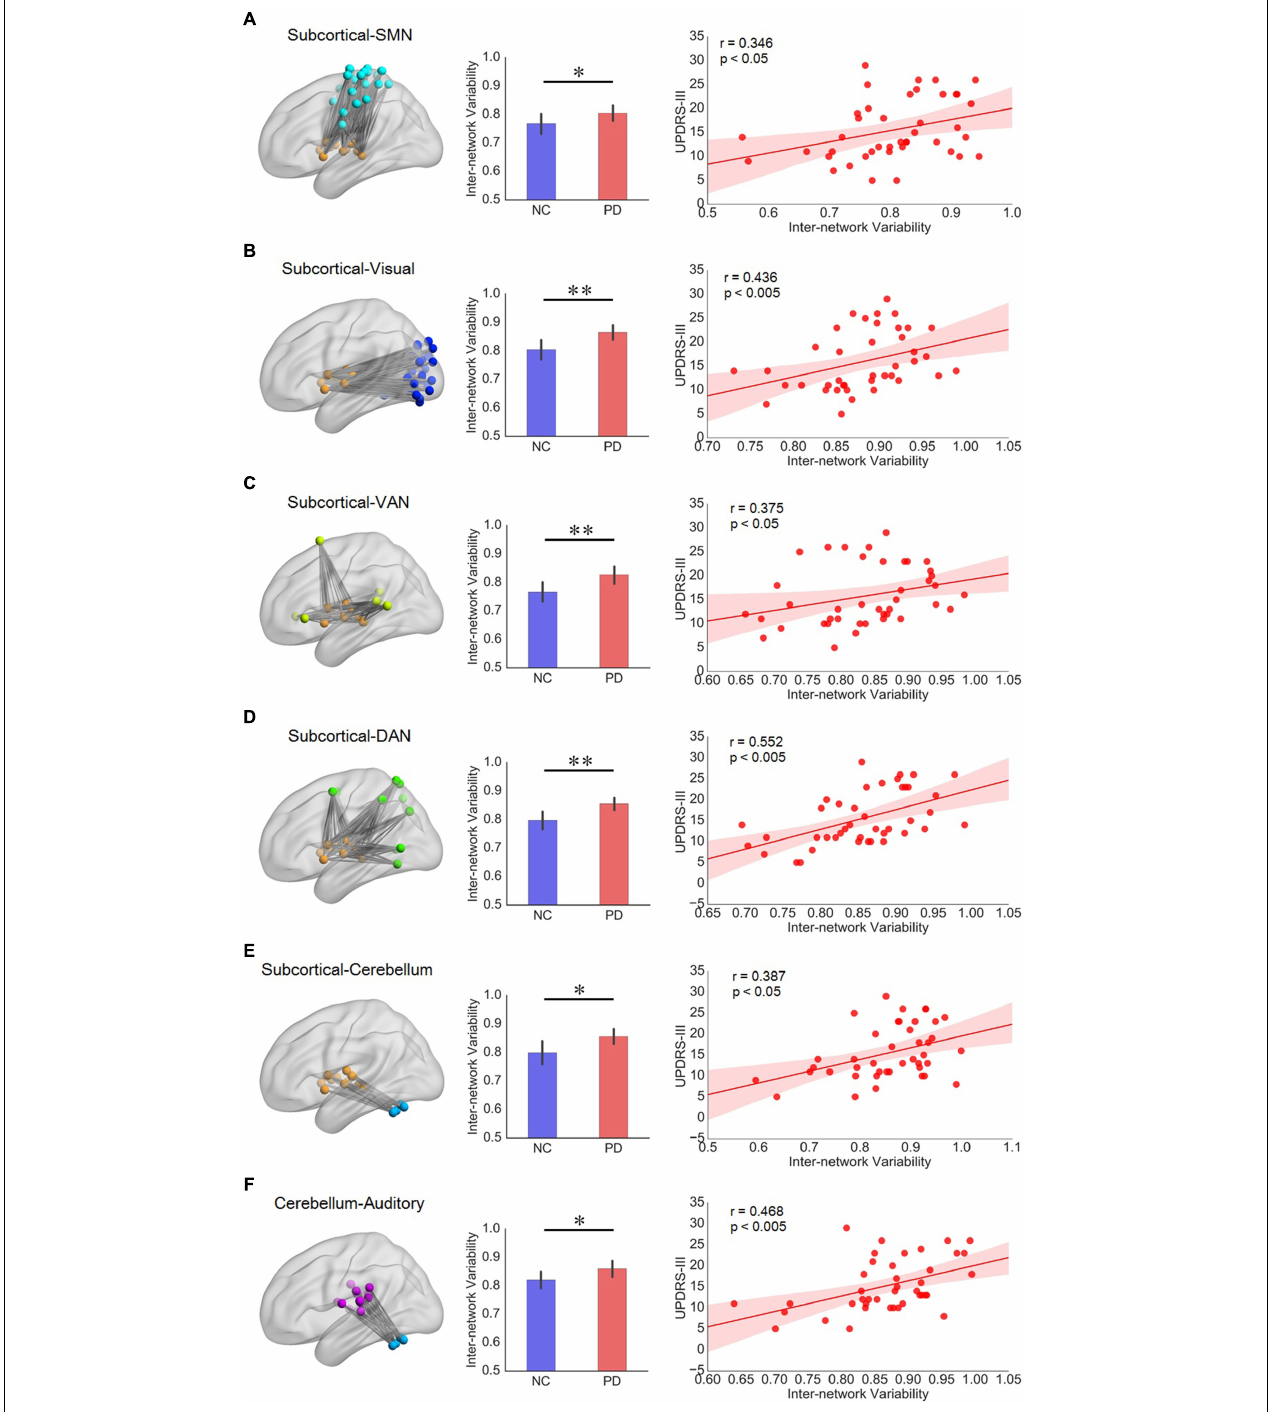
FIGURE 4 | (A–E) Subnetwork pairs associated with subcortical network had increased inter-network variability as well as significant correlation with UPDRS-III. (F) The cerebellum-auditory subnetwork pair which had increased inter-network variability as well as significant correlation with UPDRS-III in PD patients. For each row from A to F, the left panel is the topographic representation of the nodes and the inter-network connectivity within the corresponding subnetwork pairs, respectively; the middle panel is the boxplot of inter-network variability for NC and PD groups, respectively; and the right panel is the scatterplot of the inter-network variability with respect to the UPDRS-III score for PD patients, with each dot indicating one subject, excluding outliers (outside of 3 standard deviation from the group mean). Error bars represent mean and standard errors of the two groups, respectively. Linear regression line with 95% confidence interval for best-fit line (shading area), as well as r and p values (Spearman’s correlation coefficient) are provided. ∗ p < 0.05, ∗∗ p <